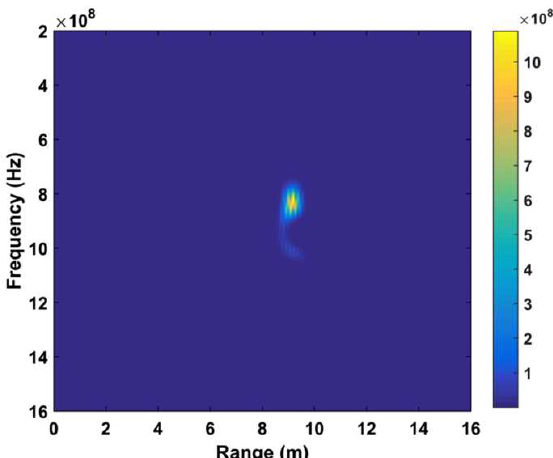
Figure 21. The STFT in the case of human location at a distance of 9 m